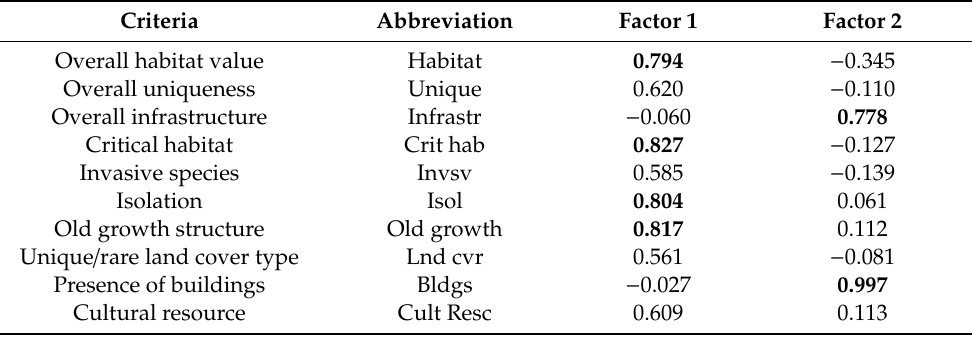
Figure A2. Plot of average silhouette widths for each number of clusters. The optimal number is two clusters. Table A1. Factor loadings for survey response data. Items with loadings > 0.7 are in bold to highlight the most meaningful variables that make up each factor.